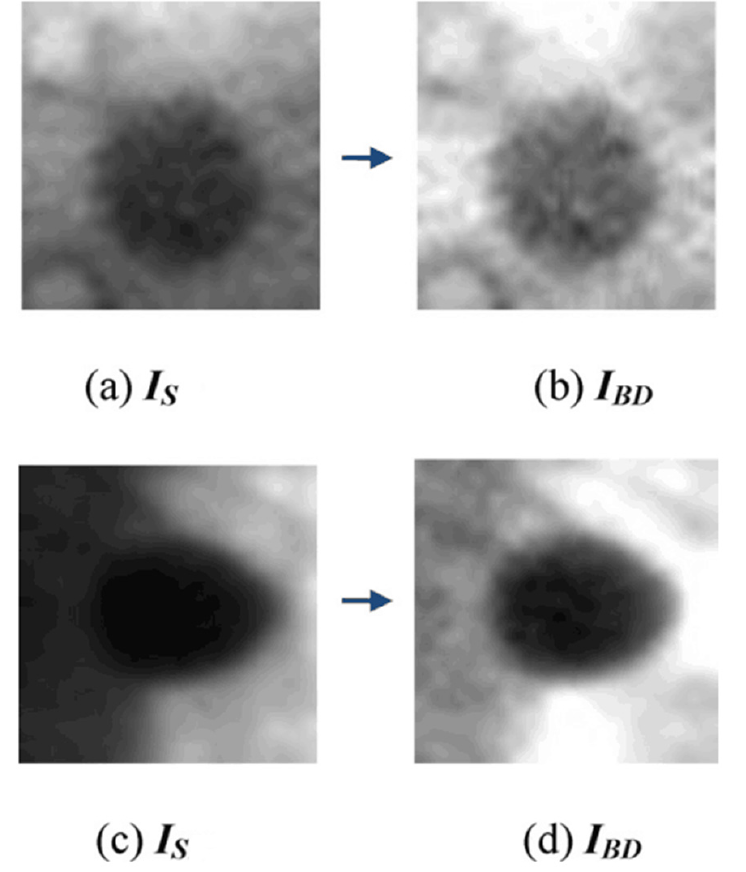
Figure 7. Image brightness nonuniformity processing [30]. Reprinted with permission from ref. [30]. Copyright 2013 Precision Engineering.